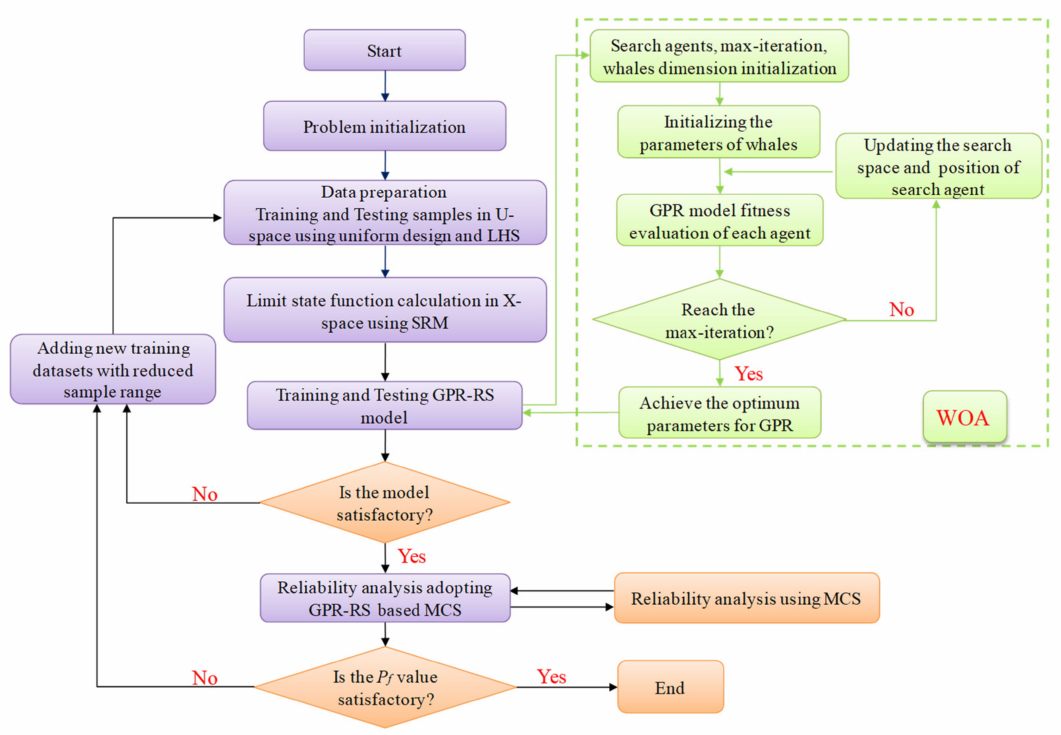
Figure 3. Slope reliability analysis considering groundwater level uncertainty based on the WOA- GPR dynamic RSM using uniform